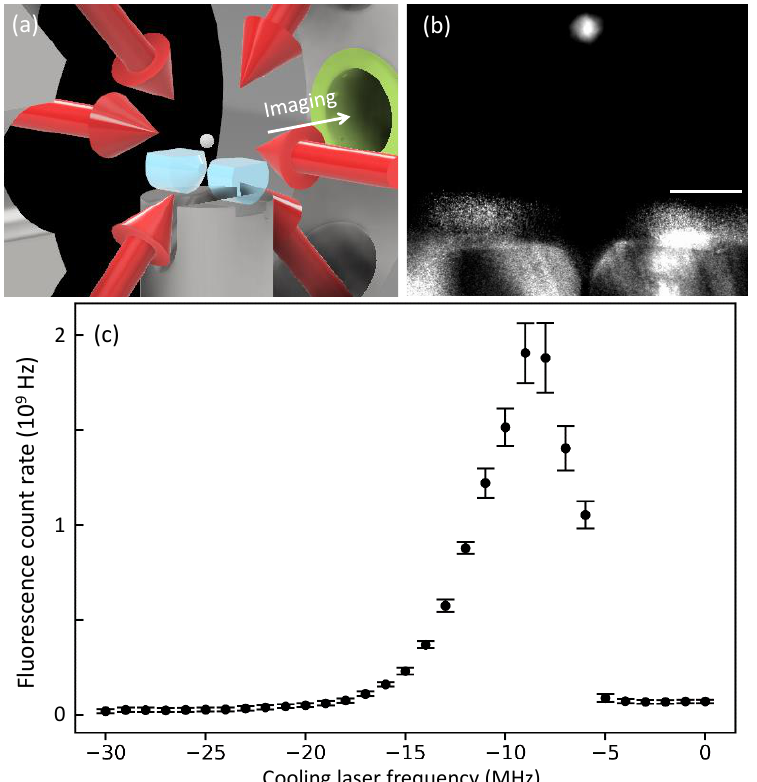
Figure 5. ( a ) Schematic of our magneto-optical trap (MOT, white ball in the center) above an optical cavity. ( b ) Fluorescence image of trapped 87 Rb atoms. Scale bar indicates 1 mm. ( c ) MOT fluorescence count rate as a function of cooling laser frequency. Error bars correspond to one standard deviation of measured count